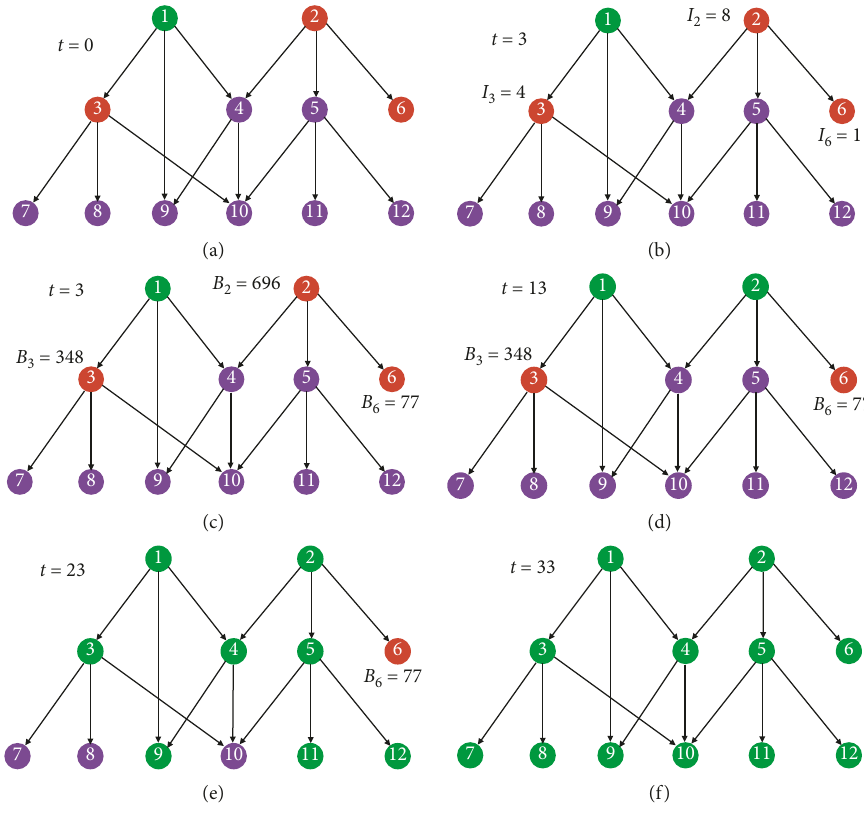
Figure 4: An example of informed recovery strategy with direct reporting mode, where T � 100, T 1. (a) Node 2, 3, and 6 are disrupted. (b) Command centre receives impact information from all disrupted nodes at t � 3. (c) The gain of each node is calculated using equation (3). Node 2 has the highest priority and thus chosen to be repaired first. (d) Node 2 is recovered at t � 13. Node 3 is the next node to be repaired. (e) Node 3 is recovered. Node 6 is the last disrupted node. (f) Node 6 is repaired, and the system is completely